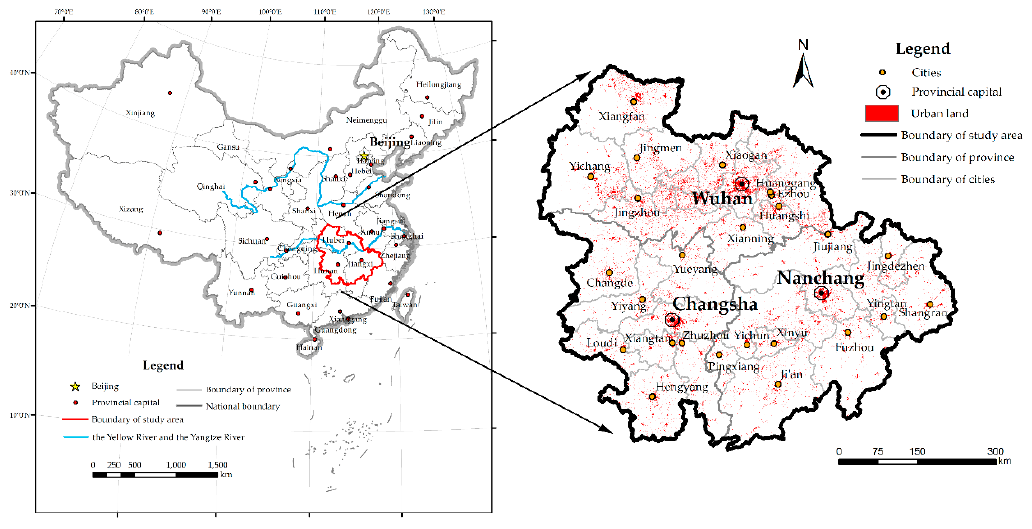
Figure 1. Location of the study area.